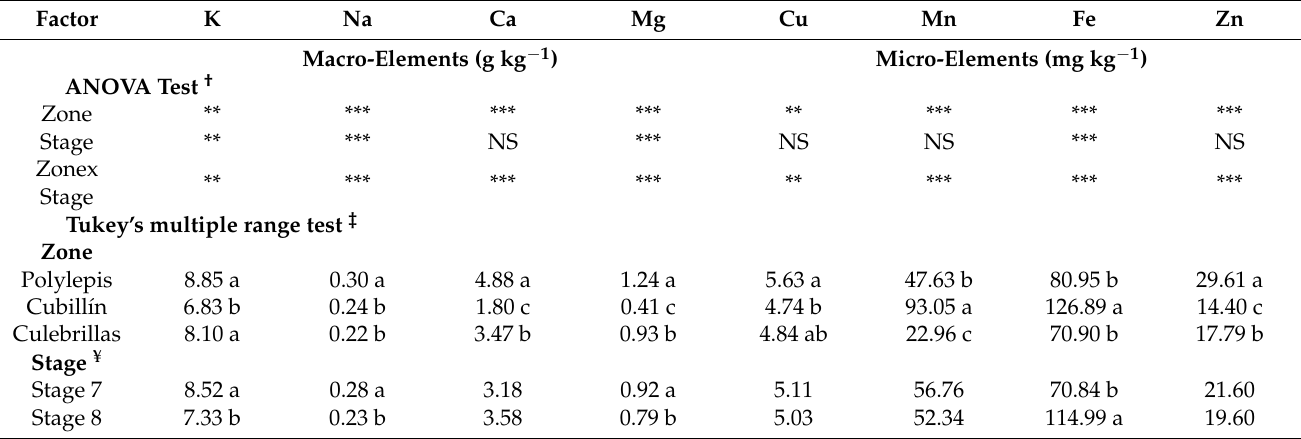
Table 4. Minerals content (g or mg kg − 1 dry matter, DM) in Mortiño berries as affected by environ- mental zone and stage of fruit